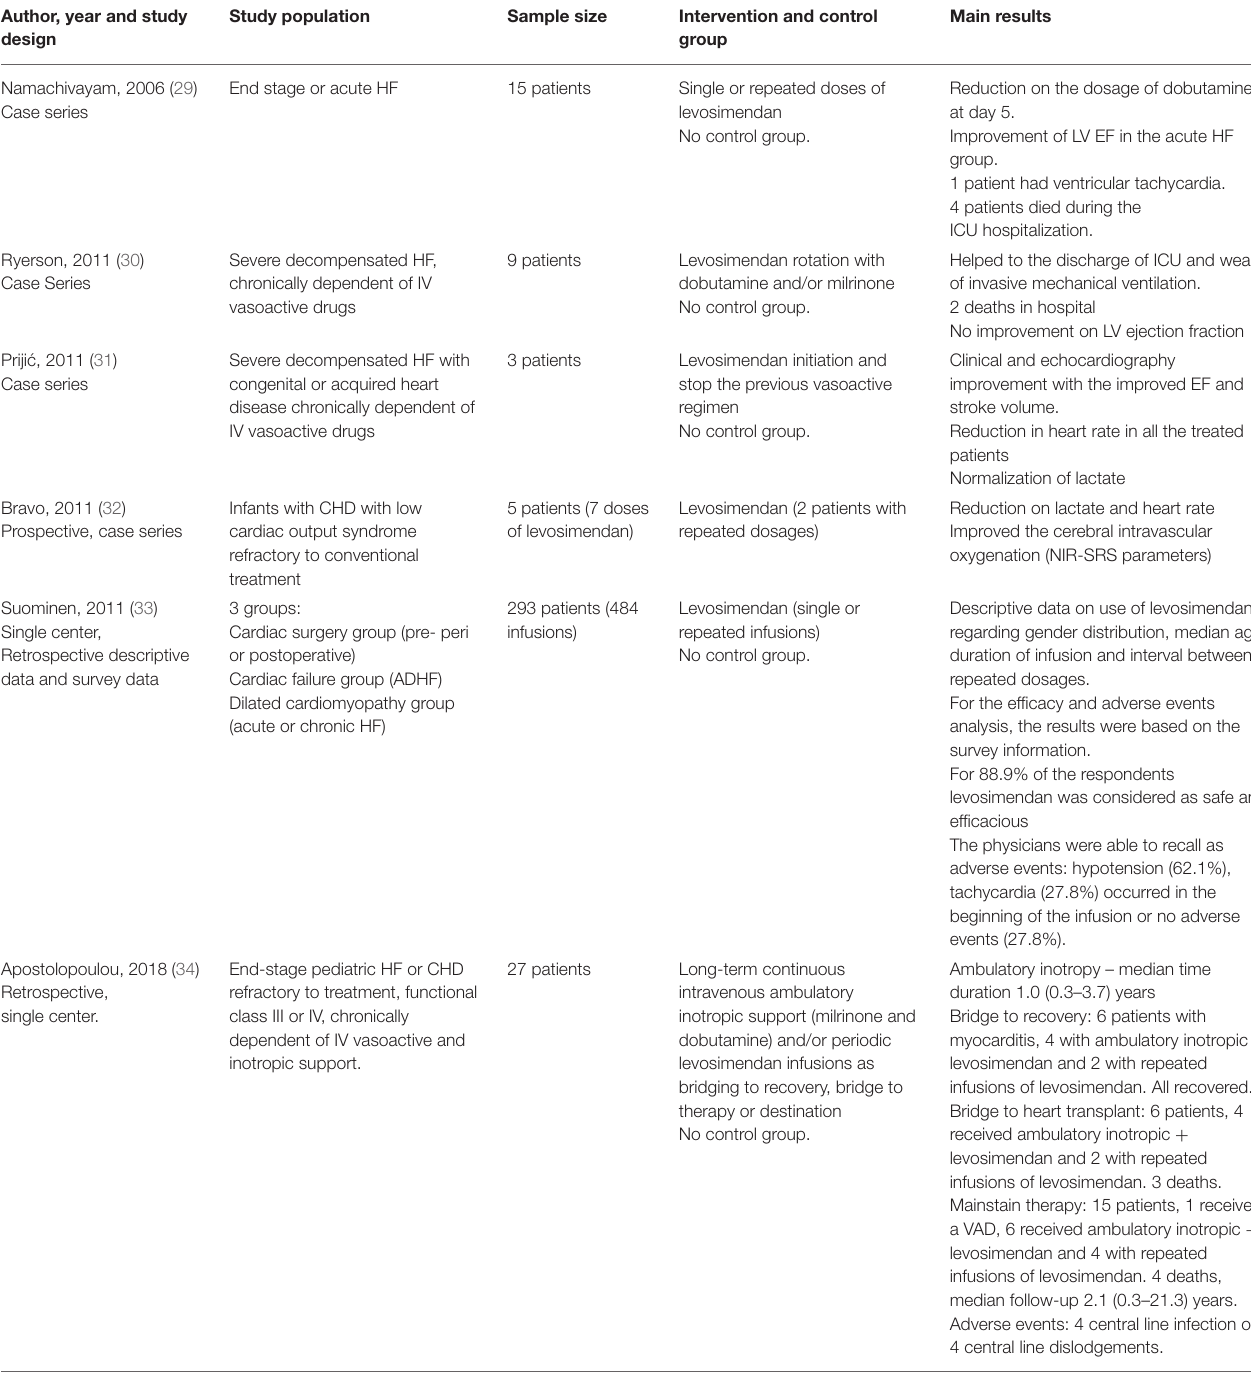
TABLE 2 | Summary of previous published papers describing the effect of levosimendan on pediatric heart failure